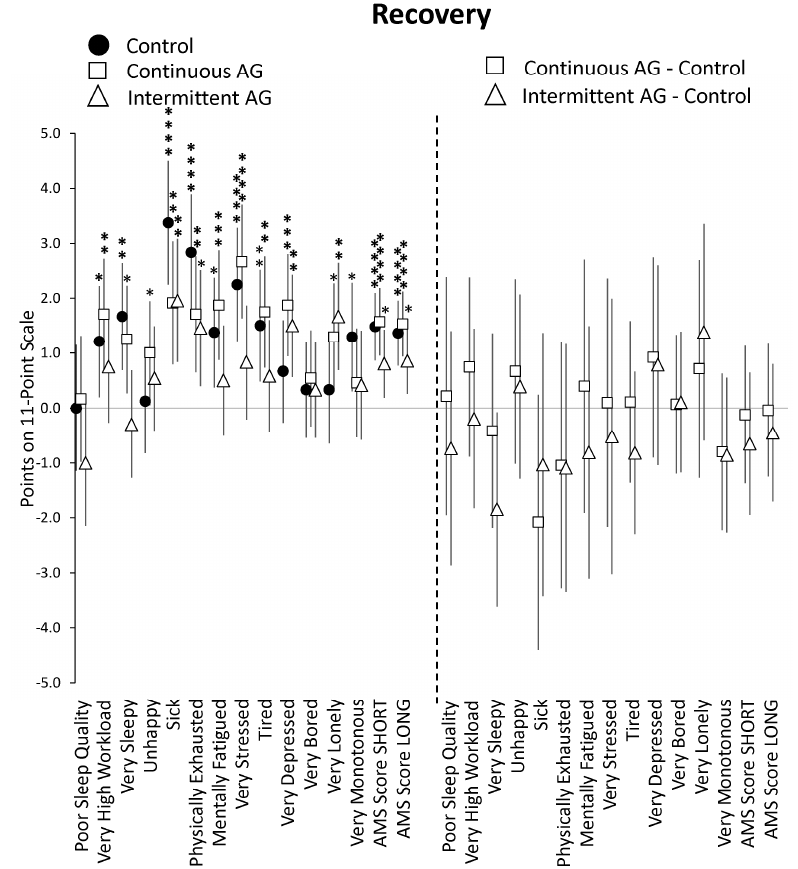
Figure 4. Change in survey responses during recovery relative to pre-head-down tilt bed rest (HDBR) baseline for the control group (black circles), continuous artificial gravity group (white squares), and intermittent artificial gravity group (white triangles). Estimates reflect points on an 11-point scale. For each variable, the negative response anchor is shown (e.g., “unhappy”, “sleepy”). Positive scores reflect more negative assessments relative to baseline (graphs on the left) or control (graphs on the right). Error bars reflect unadjusted 95% confidence intervals. Adapted from Basner et al. [16] with permission. * adjusted p < 0.05; ** adjusted p < 0.01; *** adjusted p < 0.001; **** adjusted p < 0.0001.